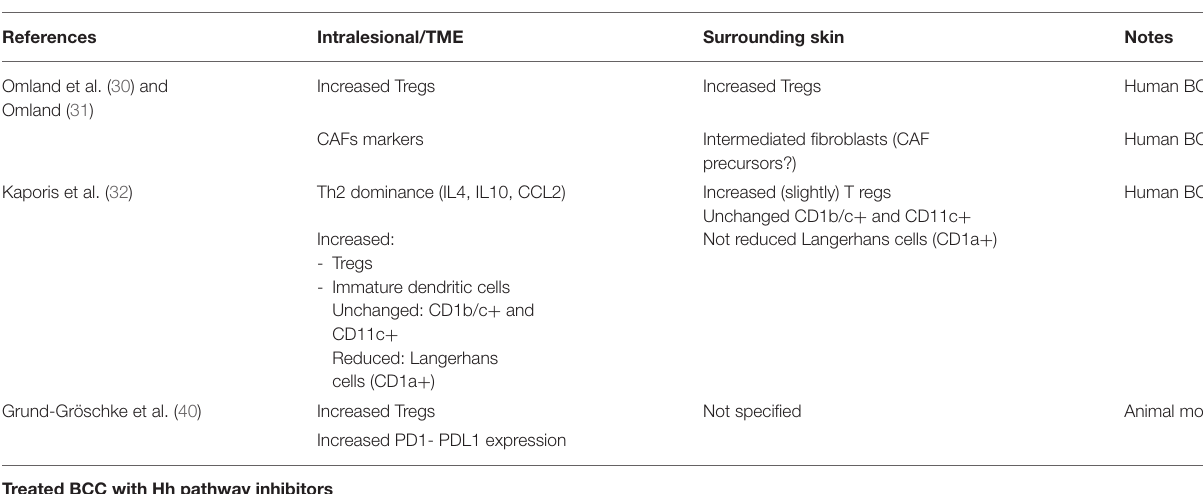
TABLE 1 | Local immunity modifications in untreated BCC and during therapy with Hh pathway inhibitors. Untreated